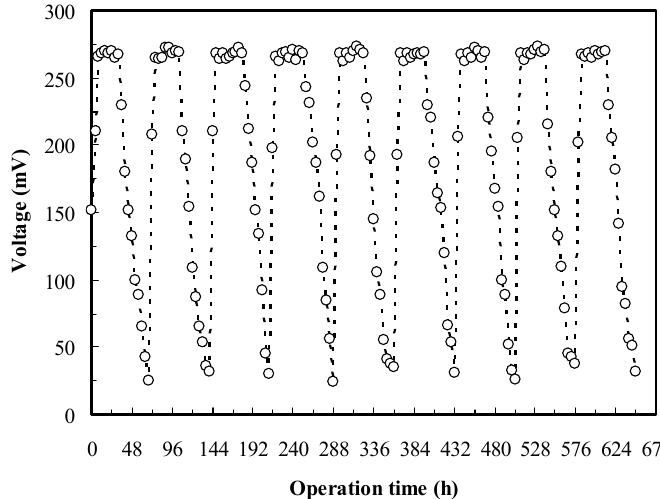
Figure 3. The stability of MFC biosensor inoculated with O. anthropi YC152 (operational temperature: 35 °C, resistance of external circuit: 270 Ω , anolyte: 1/1000 LB, catholyte: 50 mM phosphate and 25 mM NaCl).